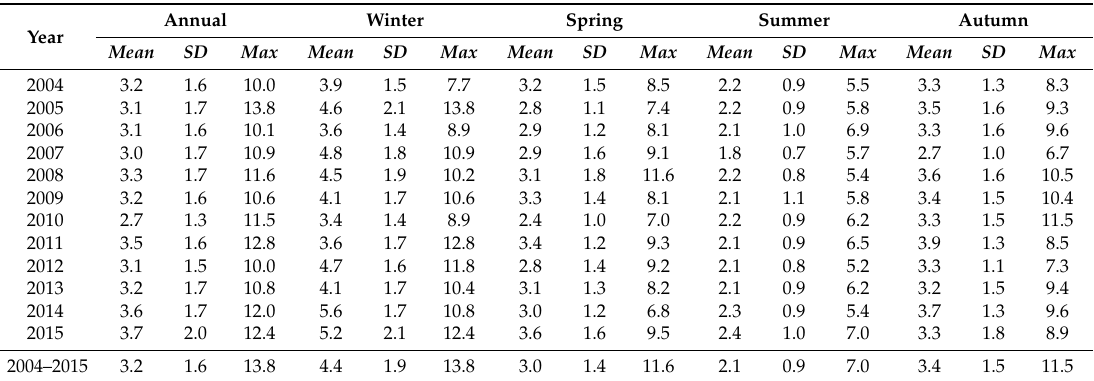
Table A1. Summary statistics from annual and seasonal analyses of H s (m) at BA.